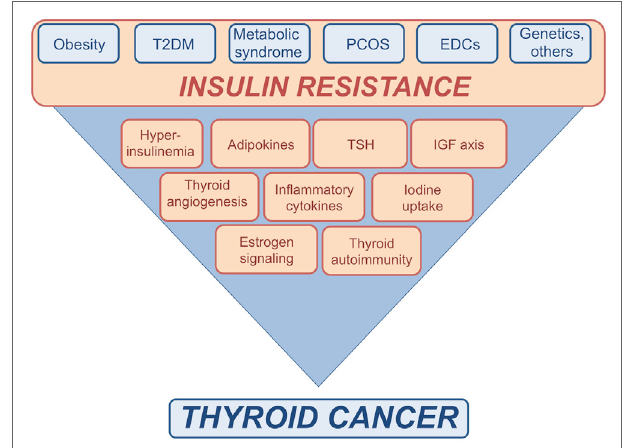
FiGURe 1 | Schematic representation of the possible links between insulin resistance and thyroid cancer (TC). Insulin resistance consequent to metabolic disorders, as well as exposure to endocrine disrupting chemicals (EDCs), genetic factors, and other conditions may affect the risk of TC by inducing or increasing various risk